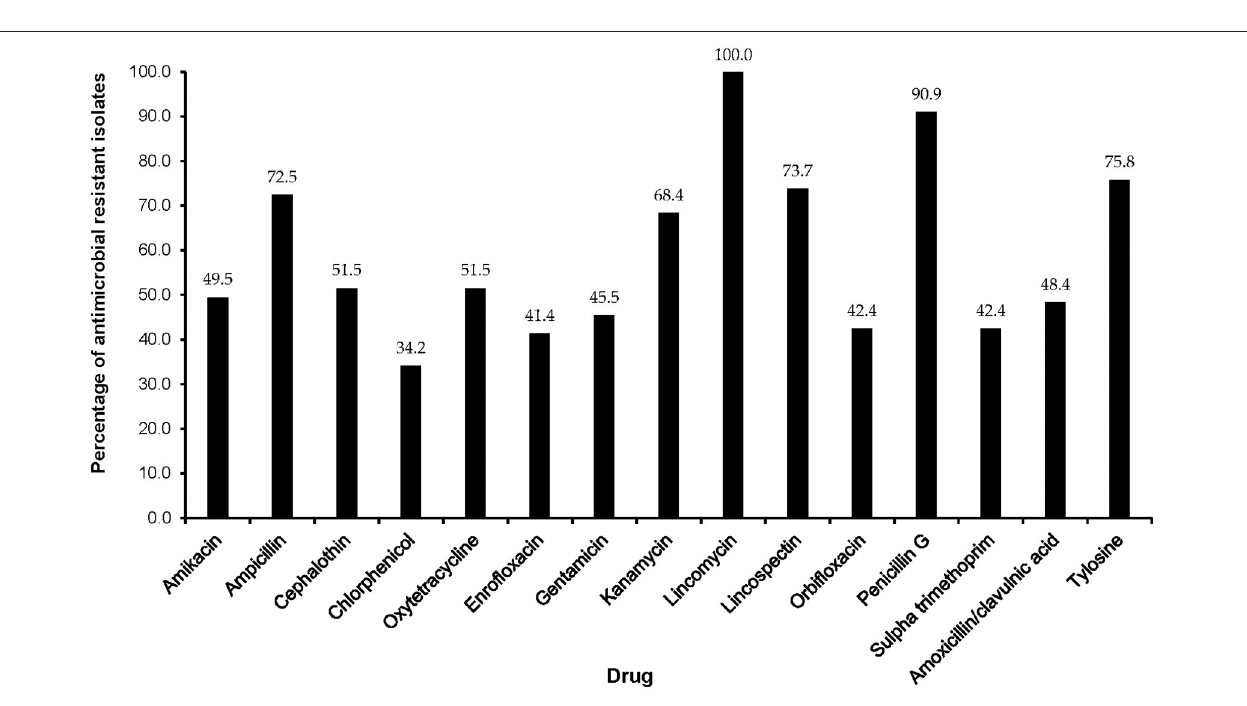
Frontiers in Veterinary Science |